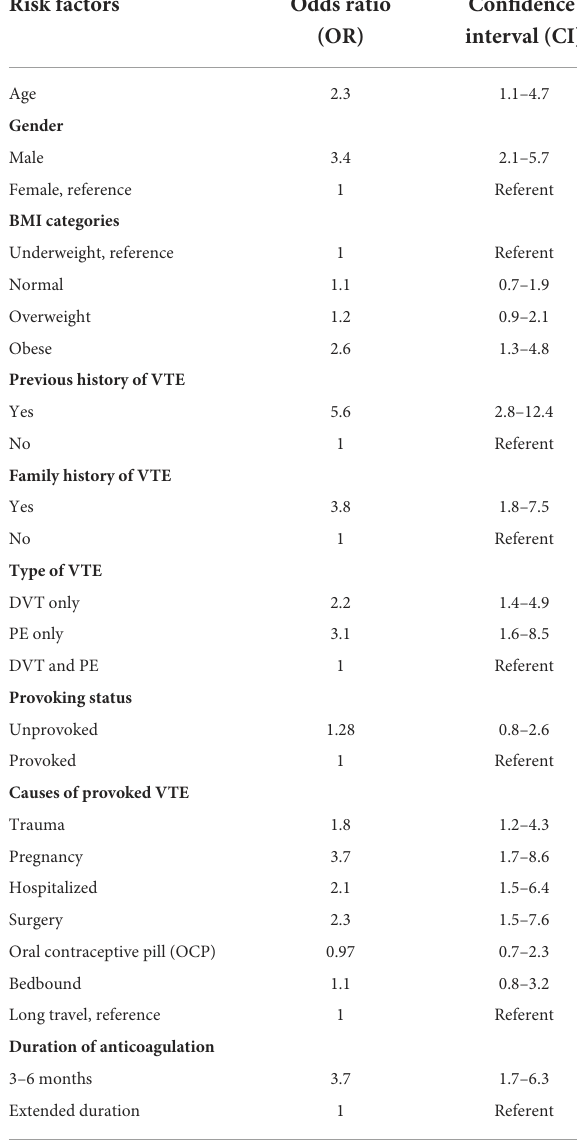
TABLE 7 Results of multivariate logistic regression analyzing the risk factors for recurrence of venous